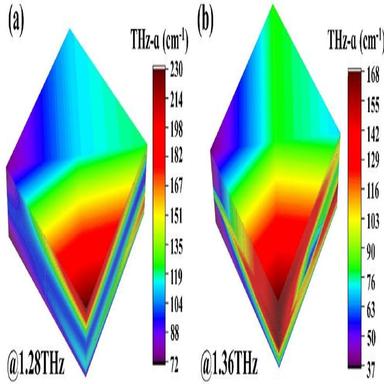
THz absorption peak tomography of the kerogen in the oil shale at different frequencies in the THz-FDS. (a) THz absorption peak tomography at 1.28 THz. (b) THz absorption peak tomography at 1.36 THz.